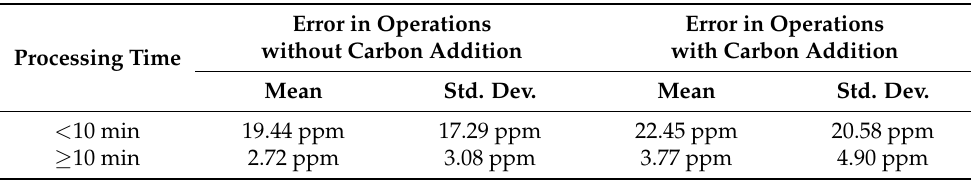
Table 1. Accuracy of the decarburization curves according to the carbon addition and operation time. The prediction error means the difference between the output of the decarburization curve and the actual amount of dissolved carbon obtained through